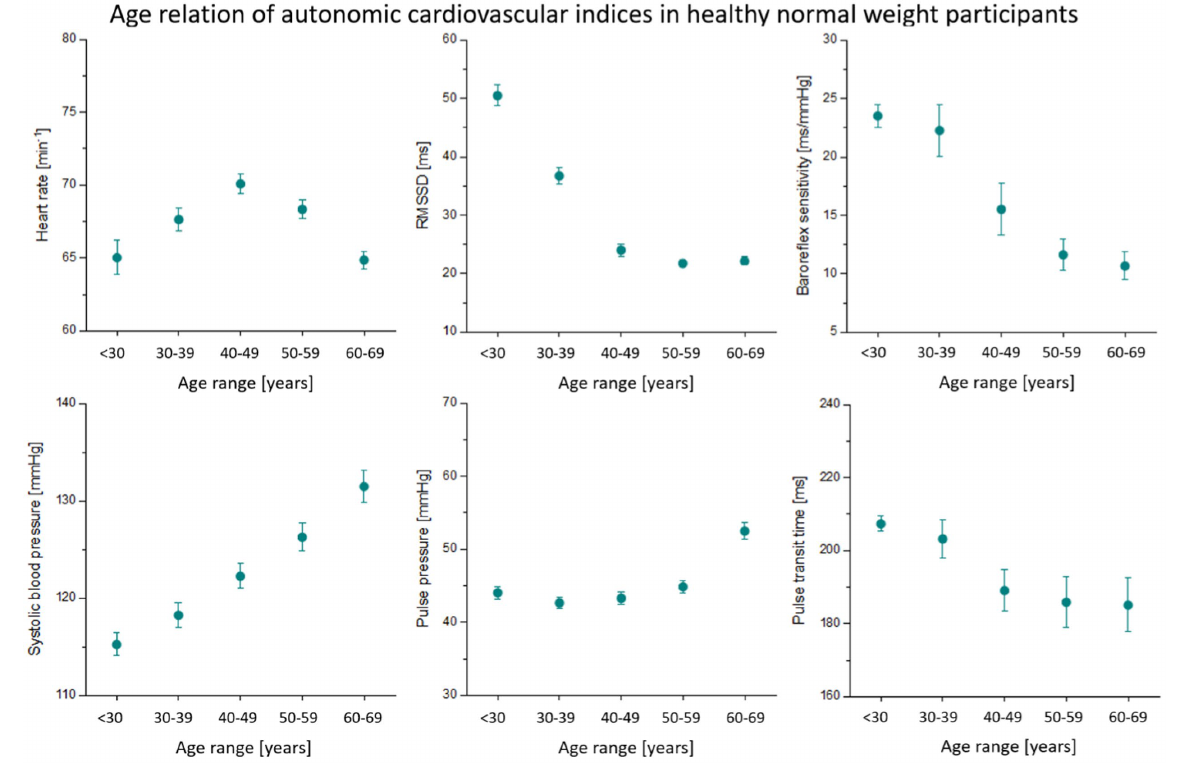
FIGURE 1 Age dependency of autonomic cardiovascular indices. Mean values and 95% confidence intervals are depicted. RMSSD, vagal heart rate variability (root-mean-square of successive heart beat